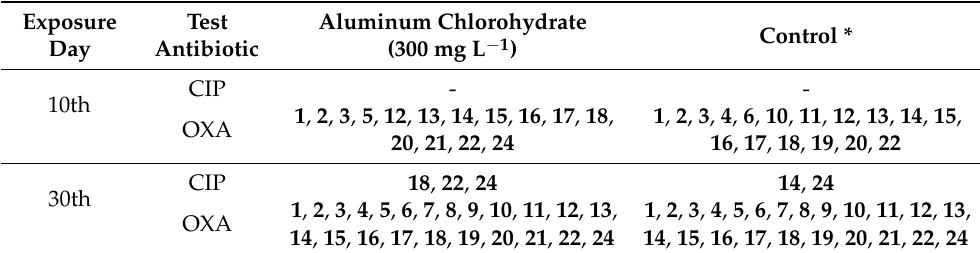
Table 1. Susceptible test bacteria that developed phenotypic resistance according to the exposure times.